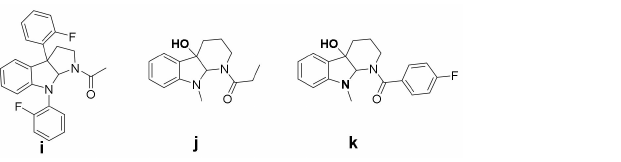
Figure 2. Representative Chimonanthus praecox compounds found by our research